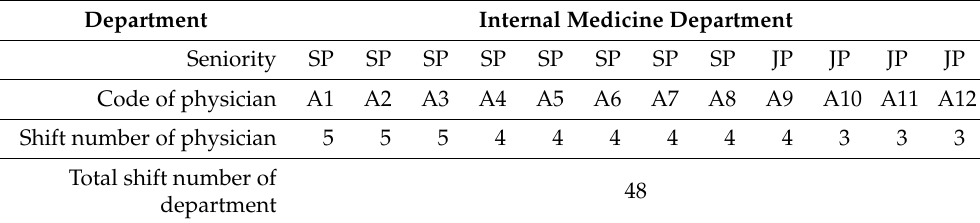
Table 1. Number of outpatient physicians.